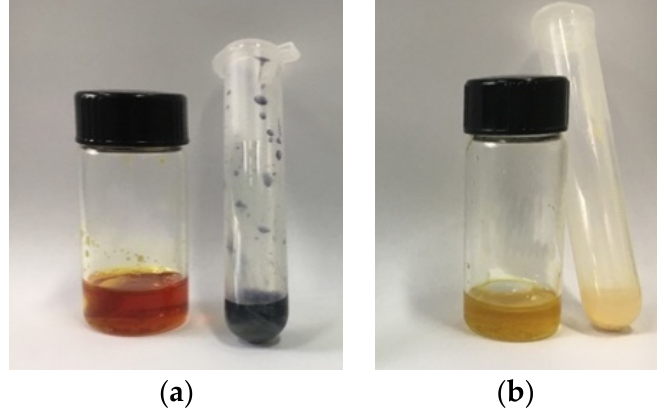
Figure 3. Mixing of ionic liquid system and starch solution: ( a ) without Au 0 , ( b ) with Au 0 .